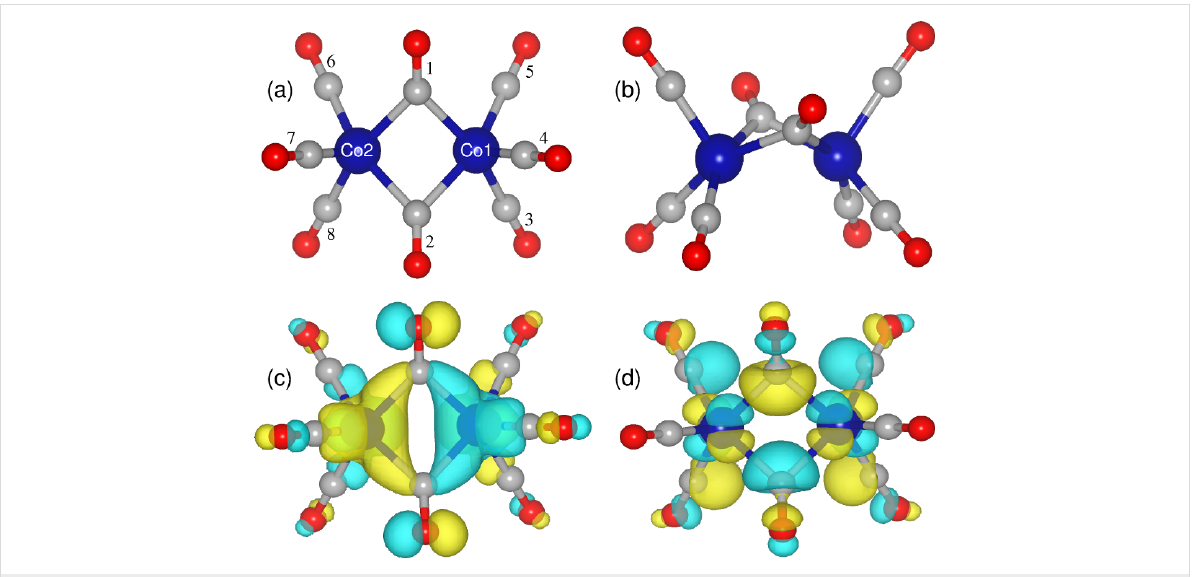
Figure 5: (a) Top and (b) side view of DFT optimized structure of Co 2 (CO) 8 and its frontier orbitals (c) HOMO and (d) LUMO. Blue, red and grey spheres represent cobalt, oxygen and carbon atoms respectively.